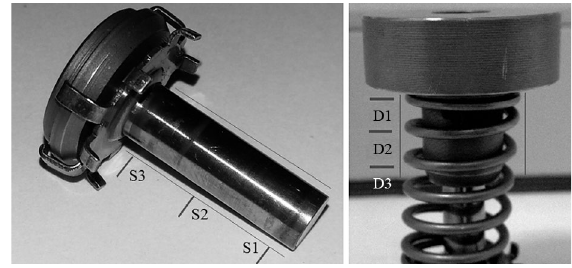
Fig. 2. Location of the points used for surface roughness and surface microstructure analysis